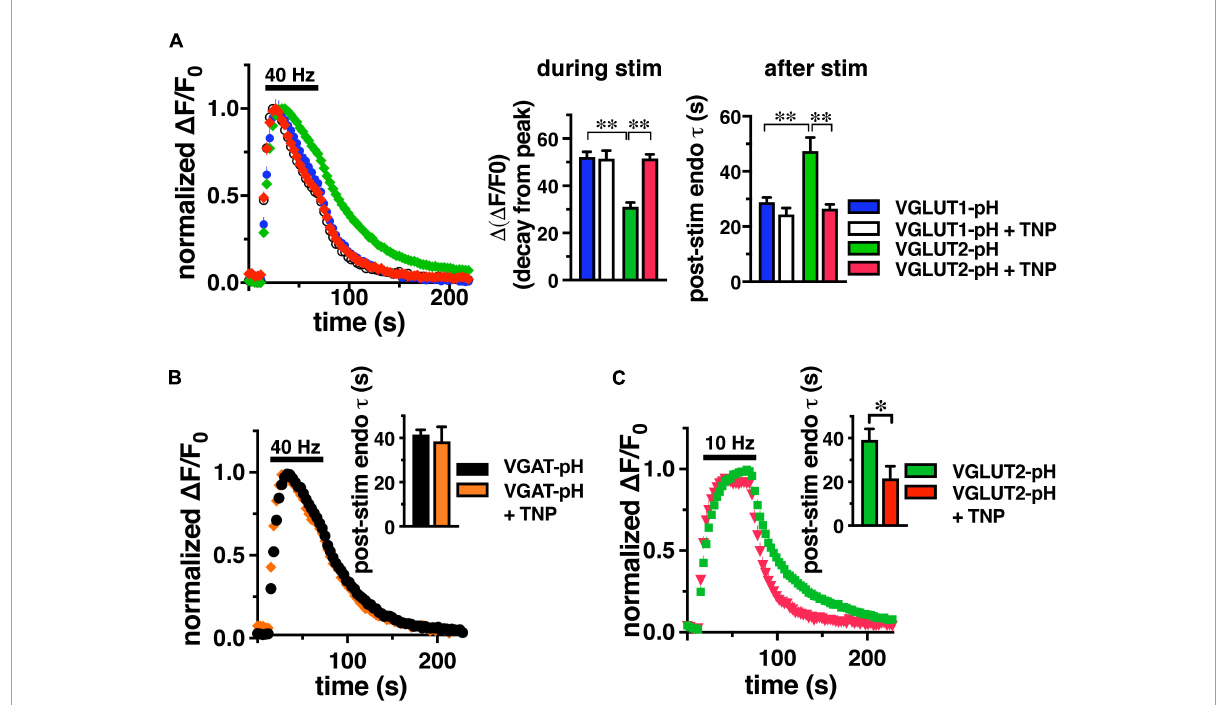
FIGURE1 IP6K inhibition accelerates the rate of VGLUT2-pH endocytosis. (A) The time course of fluorescence changes ( (cid:49) F/F 0 ) at synaptic boutons of cultured rat hippocampal neurons expressing VGLUT1-pH or VGLUT2-pH stimulated at 40 Hz for 60 s, normalized to peak fluorescence, exhibit increases and decrease in fluorescence intensity consistent with exocytosis followed by endocytosis. Treatment with 10 µ M TNP for 2 h increases the rate of endocytosis of VGLUT2-pH (red) compared to vehicle (green). VGLUT1-pH recycling (blue) is not affected by TNP (white). Middle panel: the extent of fluorescence decay from peak fluorescence [ (cid:49) ( (cid:49) F /F 0 )] during stimulation is smaller for VGLUT2 (green) than VGLUT1 (blue) ( ∗∗ p < 0.01). Treatment with TNP has no effect on the (cid:49) ( (cid:49) F /F 0 ) of VGLUT1 (white), but significantly increases (cid:49) ( (cid:49) F /F 0 ) for VGLUT2 (red, ∗∗ p < 0.01). Right panel: the rate of post-stimulus endocytosis of VGLUT2-pH in vehicle-treated neurons (green) is significantly slower than VGLUT1-pH. TNP treatment speeds VGLUT2-pH endocytosis to a rate comparable to VGLUT1-pH ( ∗∗ p < 0.01, t -test). (B) TNP treatment has no effect on endocytosis of the AP-2 cargo VGAT-pH. (C) TNP accelerates VGLUT2-pH endocytosis after a more moderate 10 Hz 60 s stimulus ( ∗ p < 0.05, t -test). Data are means ± SEM of (cid:49) F/F 0 normalized to total fluorescence, n = 5–18 coverslips (cs) from at least two independent cultures with at least 35 synapses analyzed per